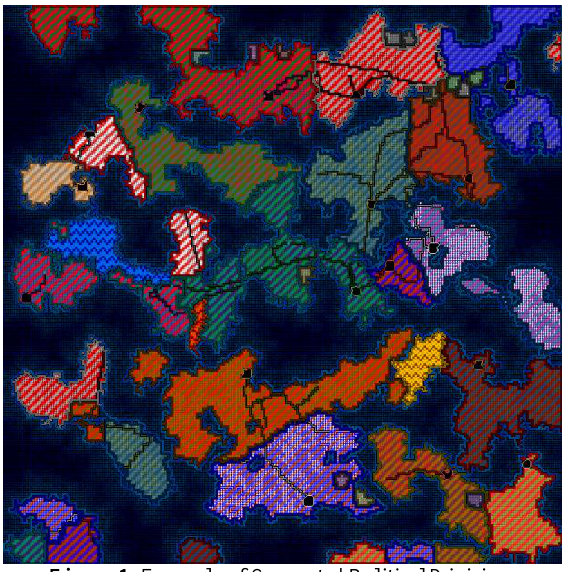
Figure 1. Example of Generated Political